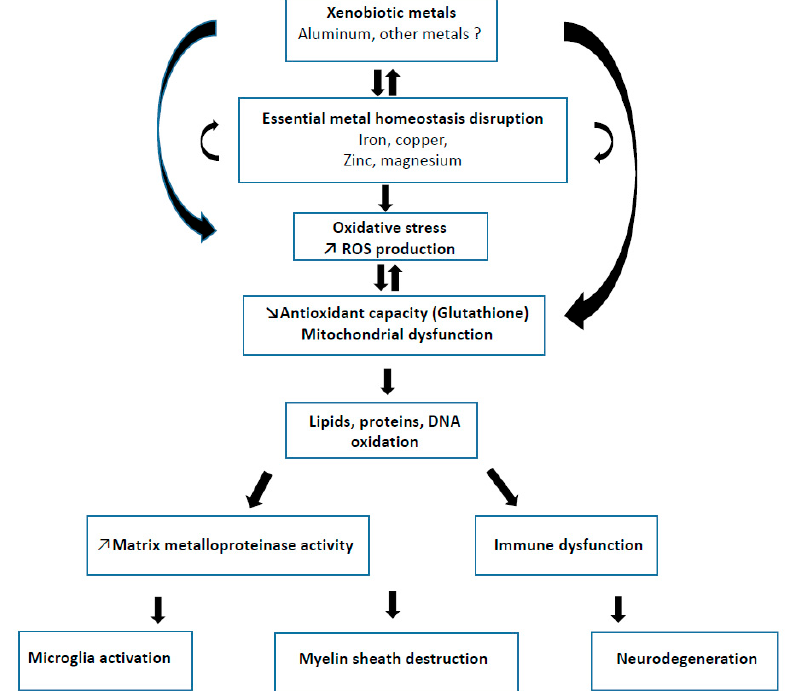
Figure 1. Schematic description of some putative xenobiotic ‐ induced metal imbalance involved in physiopathological process in CNS of MS patients. physiopathological process in CNS of MS